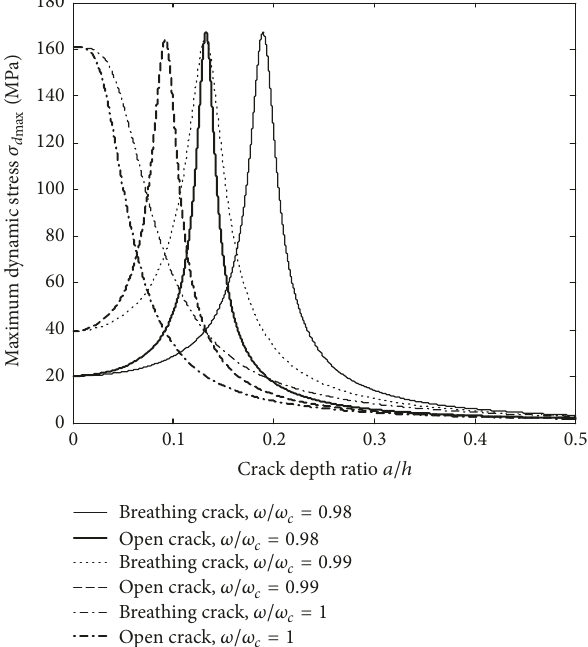
Figure 9: The maximum dynamic stress with crack severity change ( 𝜇 = 0